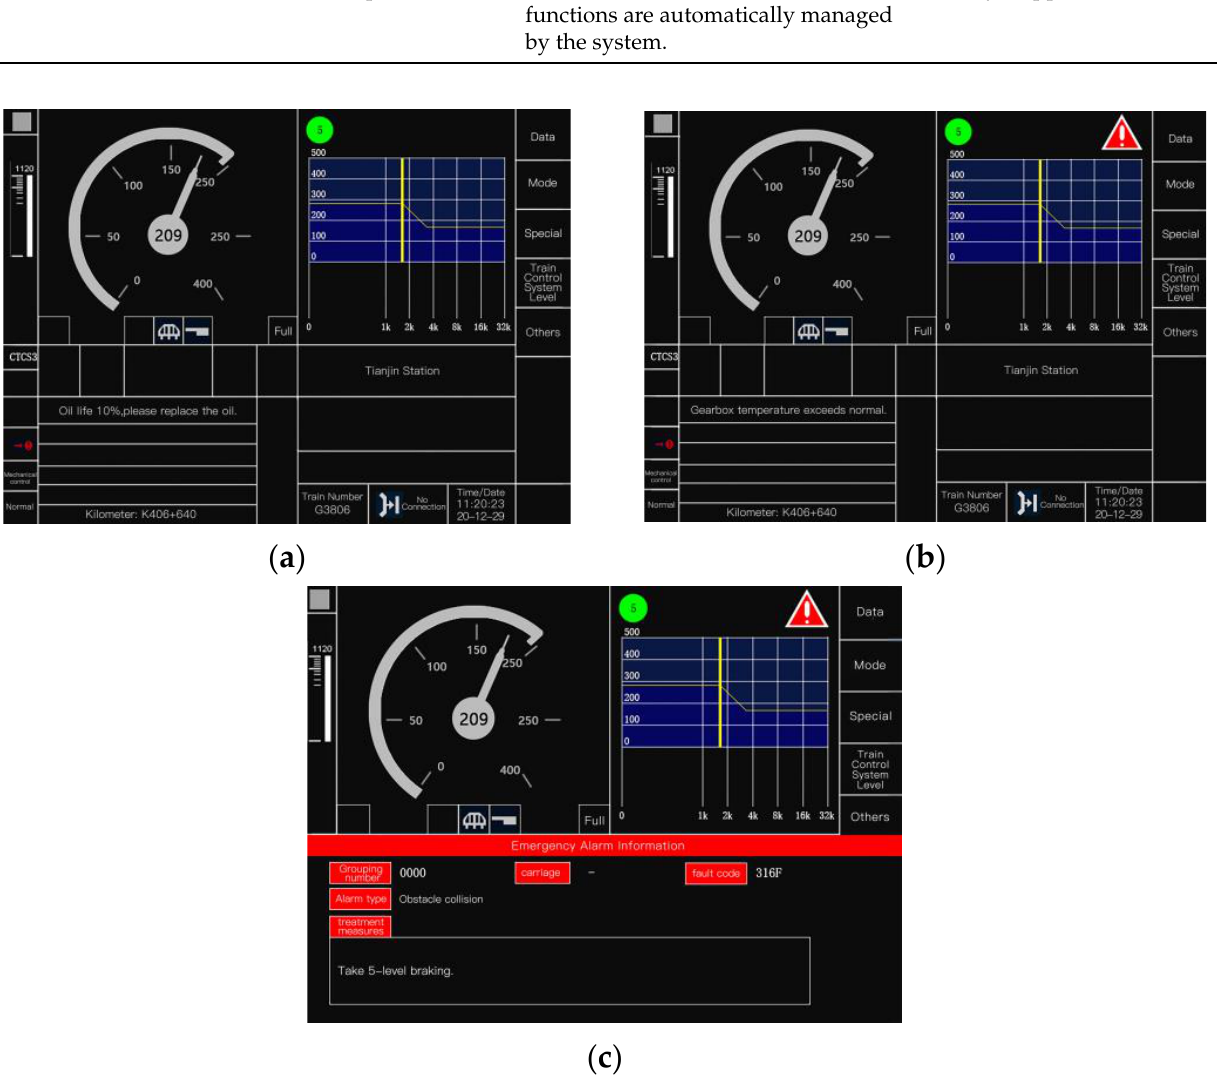
Figure 1. Warning interface of high-speed train (( a ) level 1 warning interface; ( b ) level 2 warning interface; ( c ) level 3 warning interface). Table 2. High-speed train interface warning method.